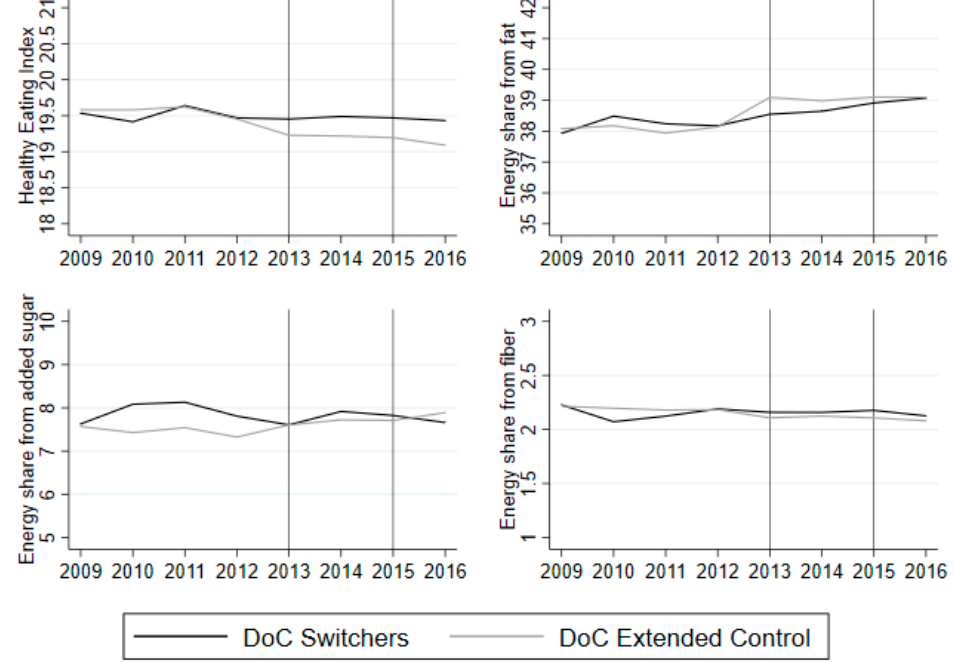
Figure A2. Average HEI and nutrient composition from 2009 to 2016 for DoC switchers (black) and extended control group (grey). Note: The vertical lines indicate the years in which the questionnaires were sent to the panel. The average is based on households that answered both questions on label use in 2013 and 2015. The averages are based on an unbalanced panel from 2009 to 2016, as not all of the household stay in the panel from 2009 to 2016. Table A7. Test of common trend of DoC switchers and extended control group.